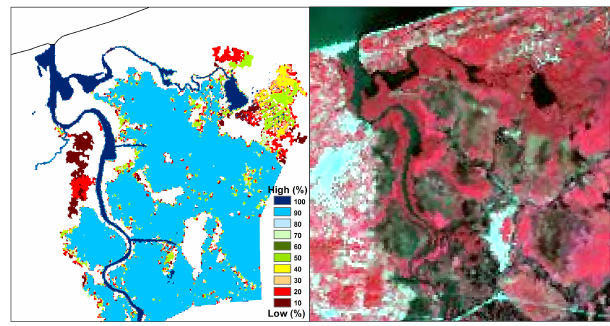
Figure 8. Data vs. model comparison of flood extent; (a) prob- abilistic flood map derived from the ensemble runs with the hy- drodynamic model; (b) infrared SPOT image corresponding to 15 November 2009.